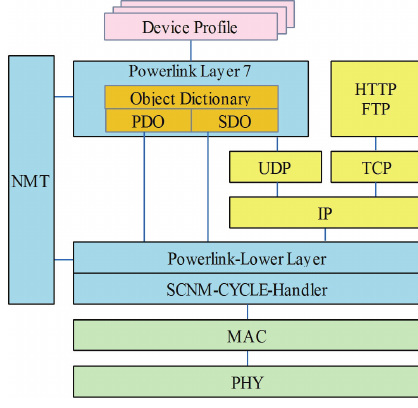
Fig. 1. Architecture of